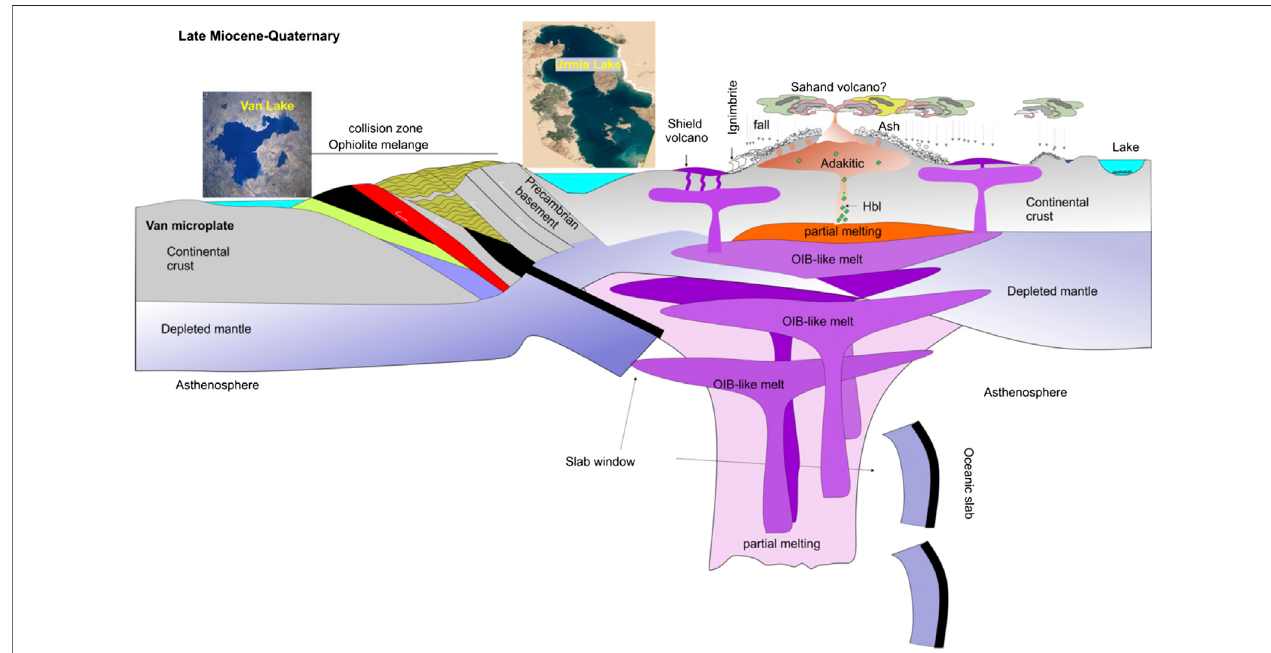
FIGURE 13 | Development of postorogenic basaltic-and-acidic volcanism during the Pliocene-Quaternary in northwestern Iran due to the slab window and injection of hot magma in the base of the lower crust, along with partial melting of earlier calc-alkaline bodies in the hot-root zone. Furthermore, during these processes, Van Lake as a foreland and Urmia Lake as a forearc basin were